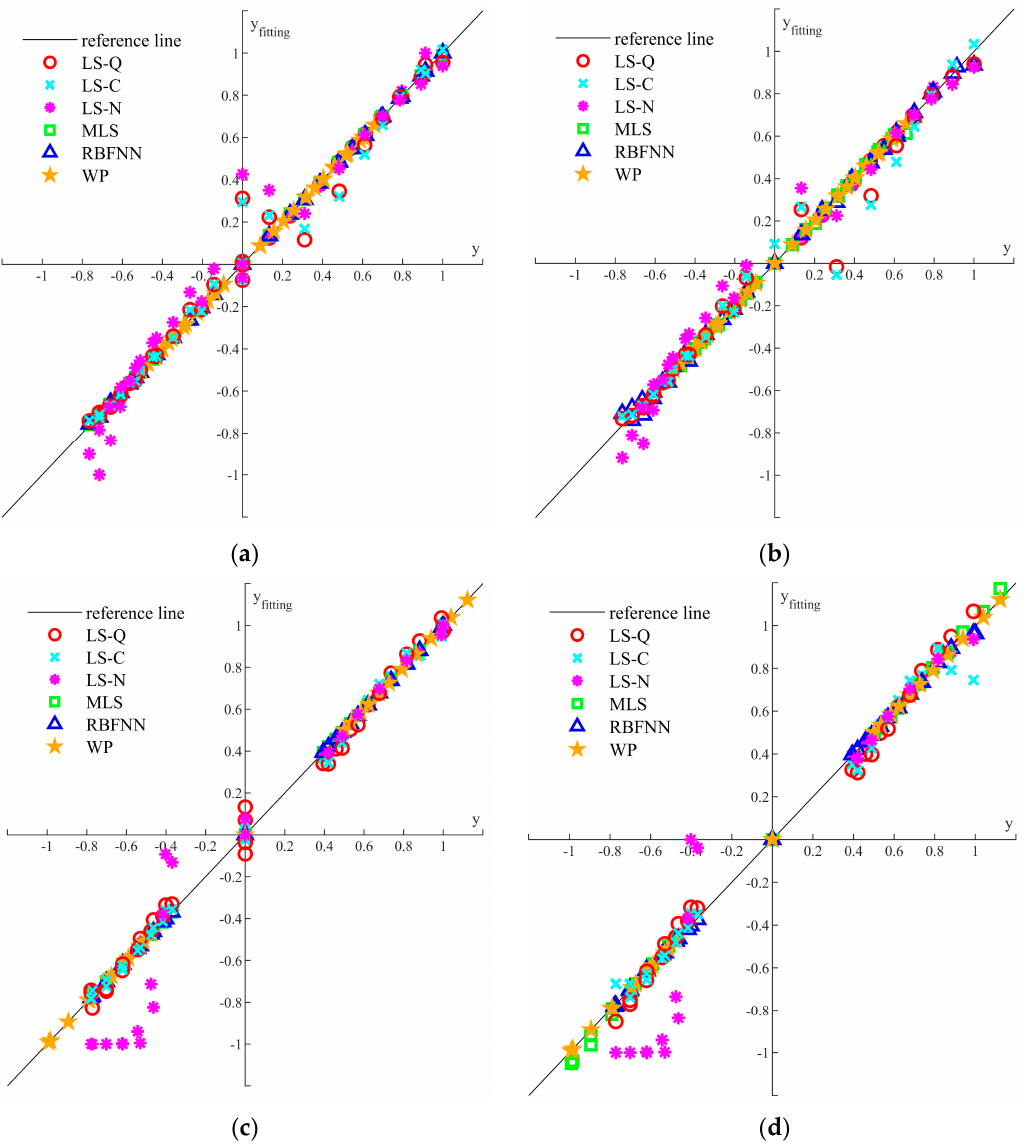
Figure 11. Accuracy comparison of fitting results for ( a ) DB in Case 1, ( b ) DB in Case 2, ( c ) DT in Case 1, and ( d ) DT in Case 2 . Table 6. Maximum error and MSE for TD1.